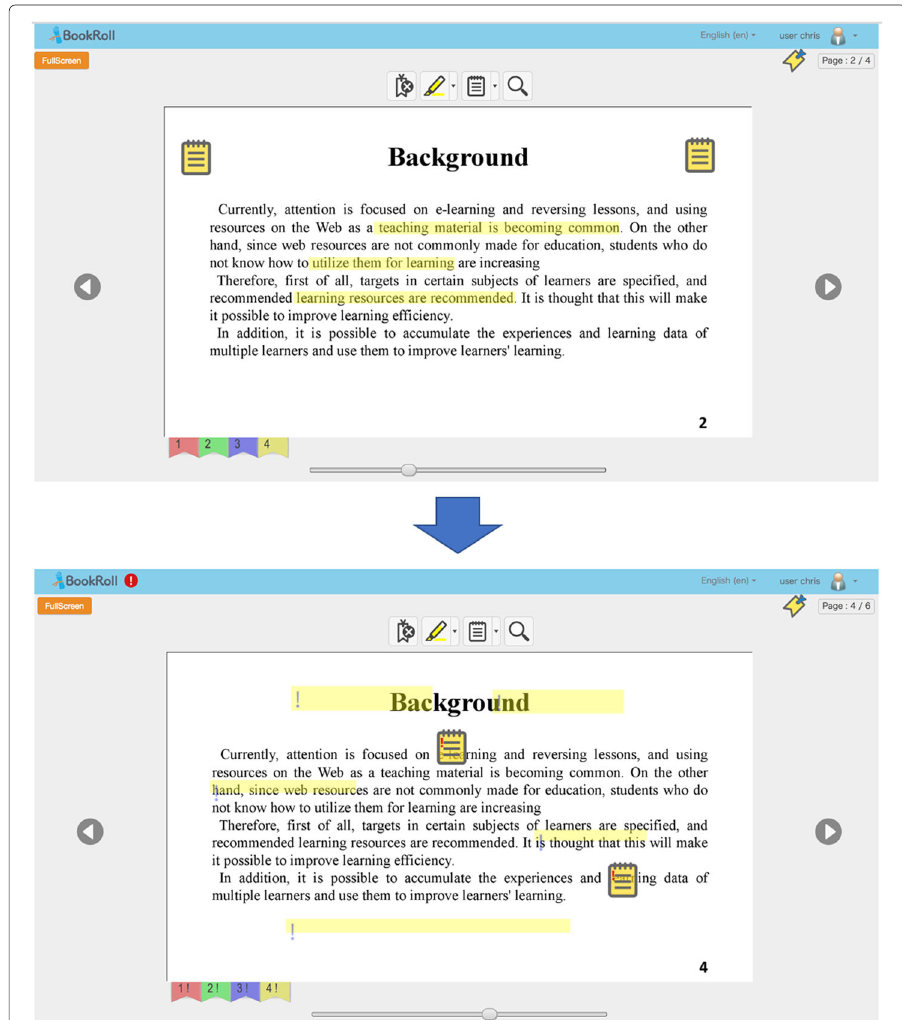
Fig. 1 Learning footprint transferring problem on an e-book